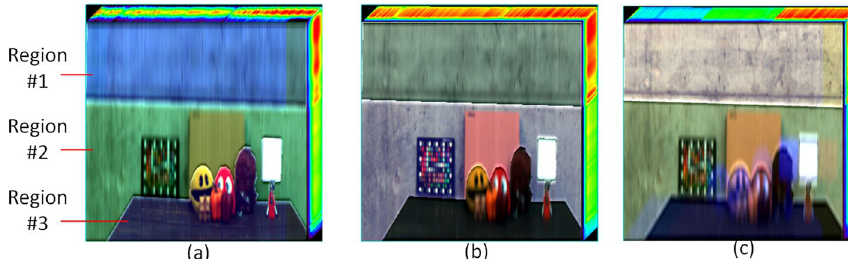
Fig. 7 The reconstructed datacube, a is the refocused datacube at depth of datacube at depth of 0 mm, c is the refocused datacube at depth of 2